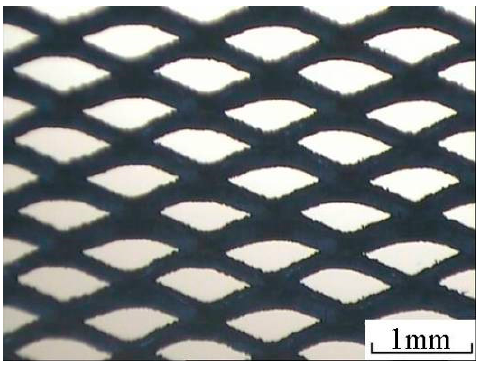
Figure 4. Micro morphology of electrode substrate MEA.